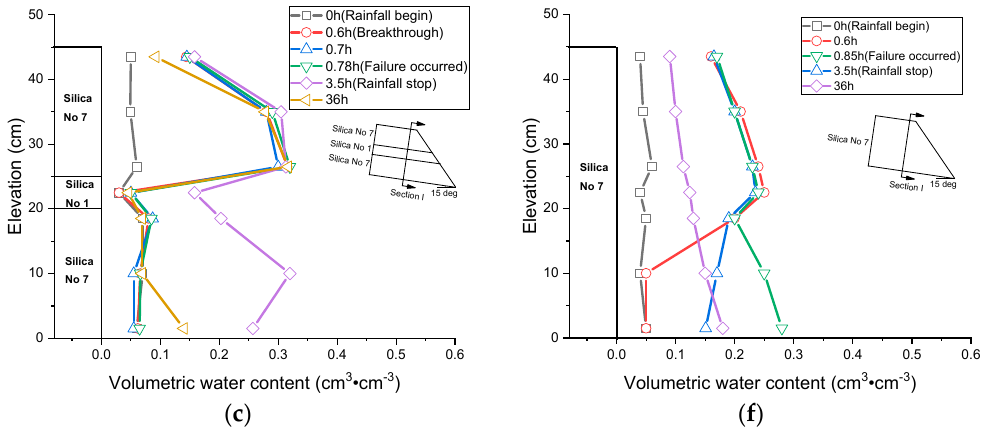
Figure 9. Profile of the VWC in section I in different cases (the VWC distribution after slope failure was verified by obtaining soil samples from various locations at the end of the experiments). ( a ) Case I; ( b ) Case II; ( c ) Case III; ( d ) Case V; ( e ) Case VI; ( f ) Case VII.